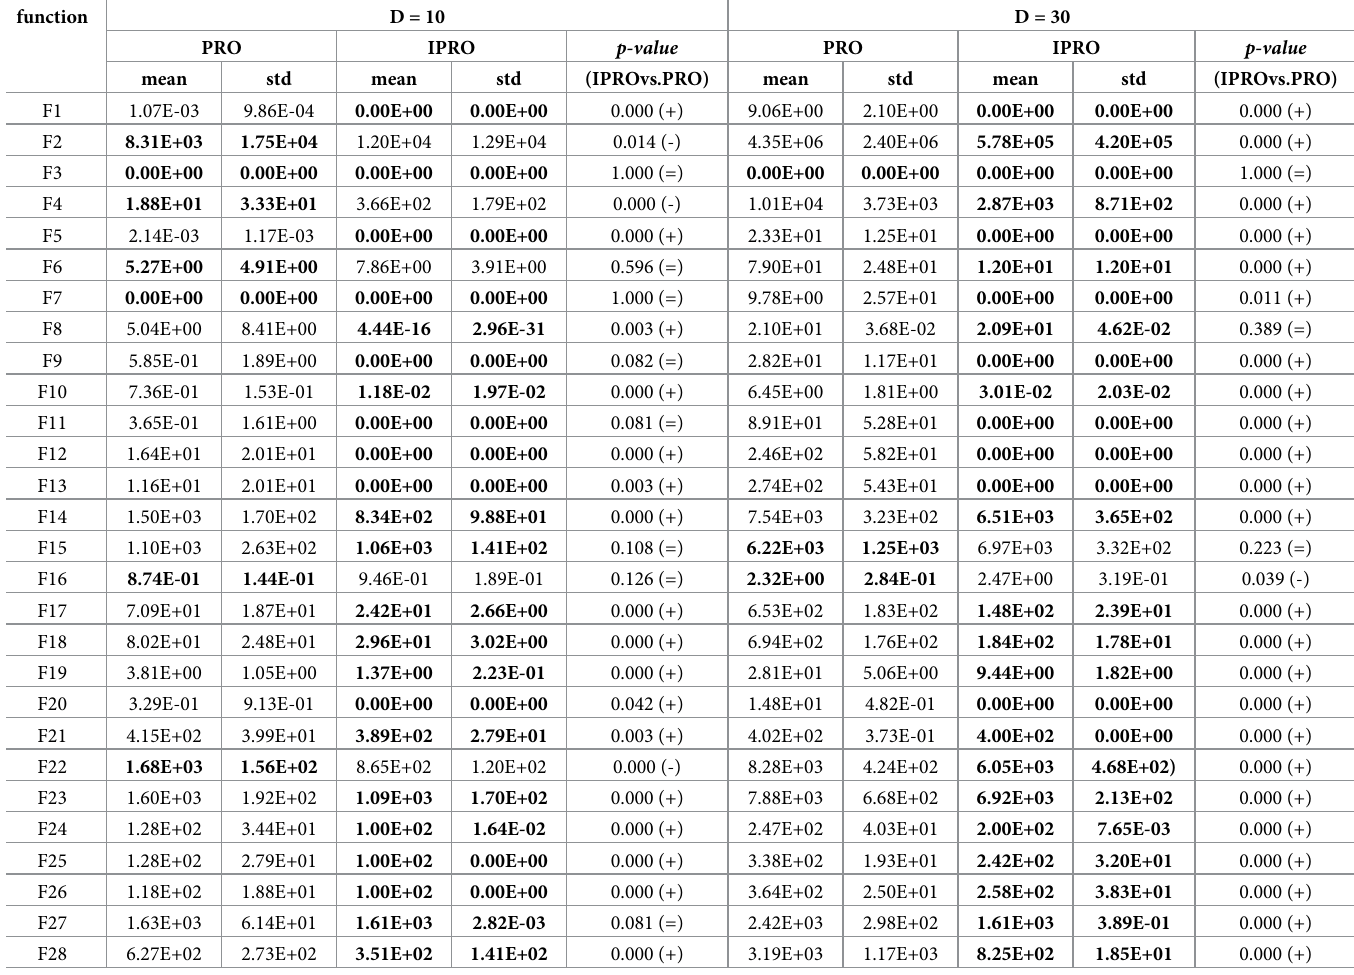
Table 5. Comparison results of IPRO and PRO on CEC2013 test suite.